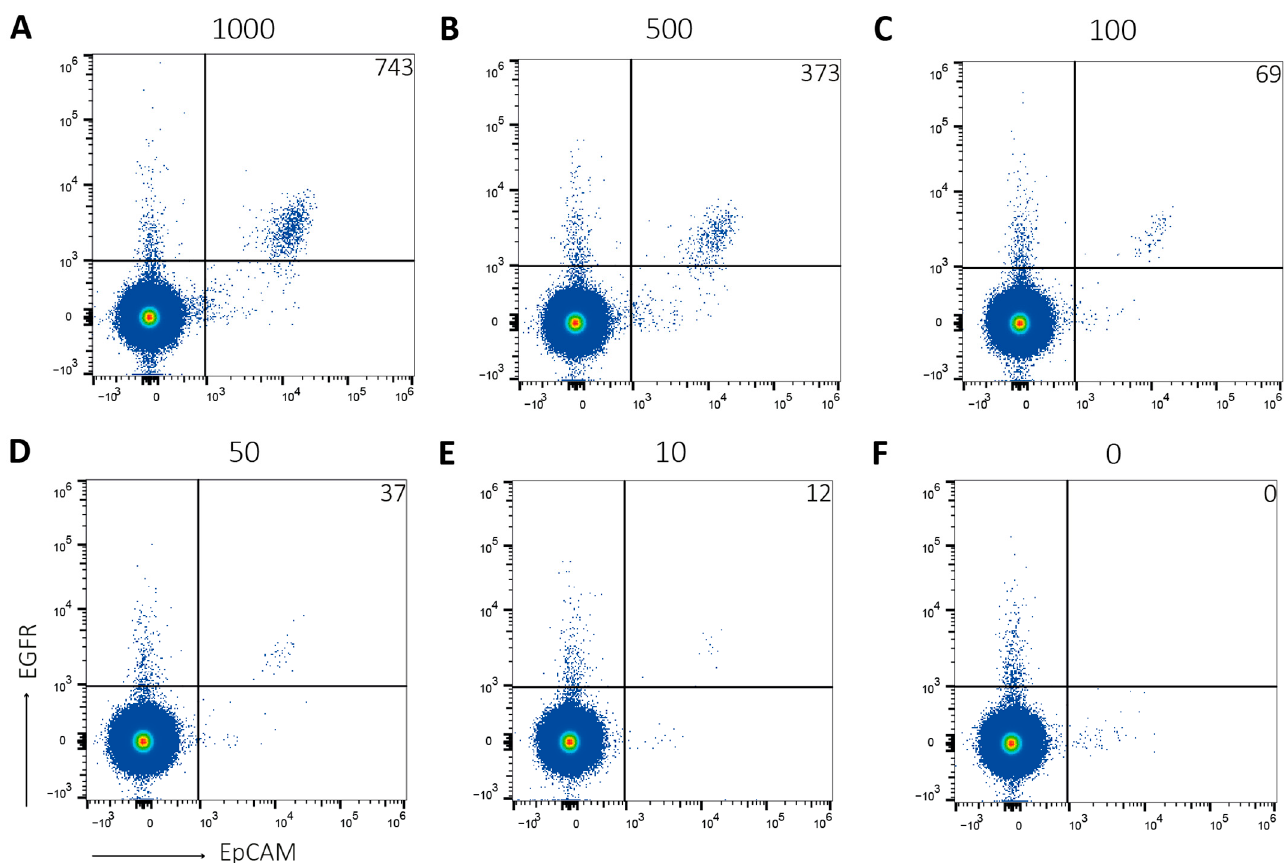
Figure 1. On average, 75% of tumor cells can be detected using the Attune NxT. Healthy donor blood was either ( A ) spiked with 1000 HCT116 cells, ( B ) 500 HCT116 cells, ( C ) 100 HCT116 cells, ( D ) 50 HCT116 cells or ( E ) 10 HCT116 cells, or ( F ) non-spiked. After PBMC isolation, samples were stained for EpCAM and EGFR, and analyzed using the Attune NxT. Tumor cells were detected by EpCAM+EGFR staining. Number of detected tumor cells is indicated in upper right corner. Repre- sentative figure of N = 3.